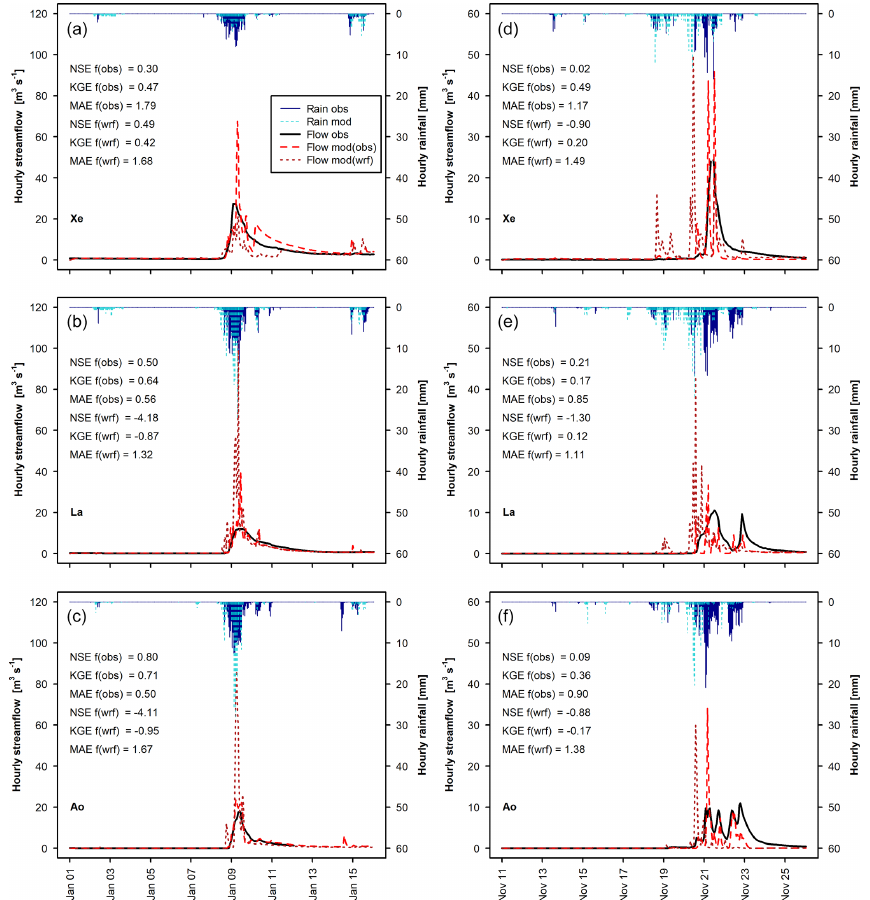
Figure 10. Observed hourly hydrographs (Flow obs) and hydrographs obtained with the calibrated WRF-Hydro model (Flow mod) forced with observed rainfall (Rain obs) and with WRF-modelled rainfall (Rain wrf) for both January 1989 (a–c) and November 1994 (d–f) , for three watersheds (see Table 1 for watershed abbreviations); modelled flow performance indices (NSE, Nash–Sutcliffe efficiency; KGE, Kling–Gupta efficiency; BIAS) are shown as